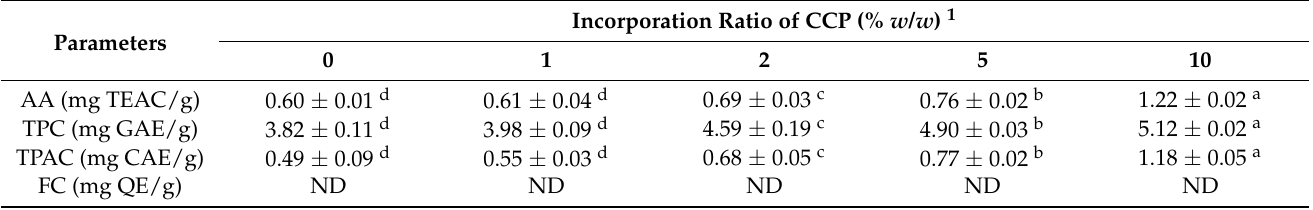
Table 3. Antioxidant activity and selected polyphenolic compounds of experimental bread loaves.